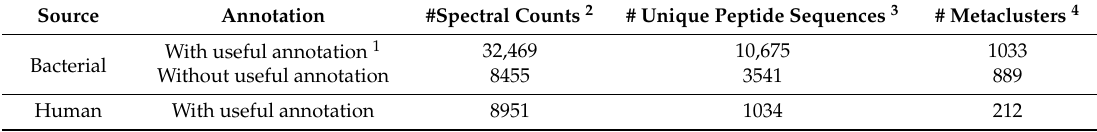
Table 1. Assignment of spectral counts to unique peptide sequences and metaclusters.